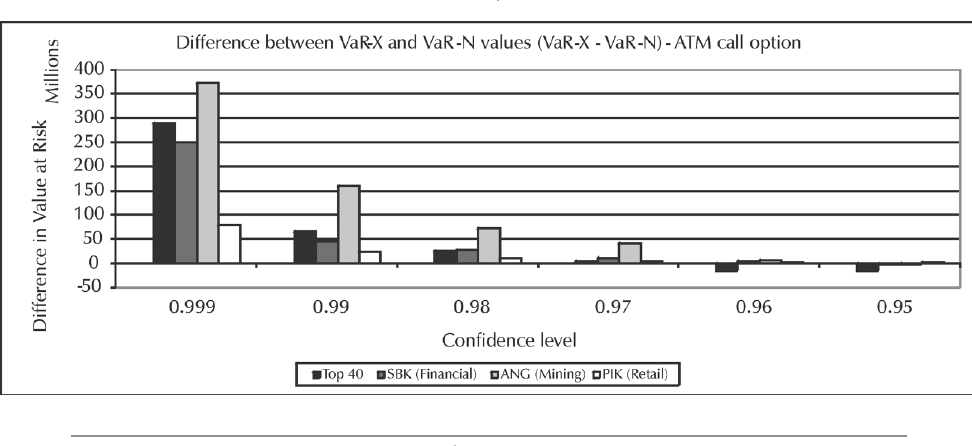
Difference between ATM call option VaR-N and VaR-X